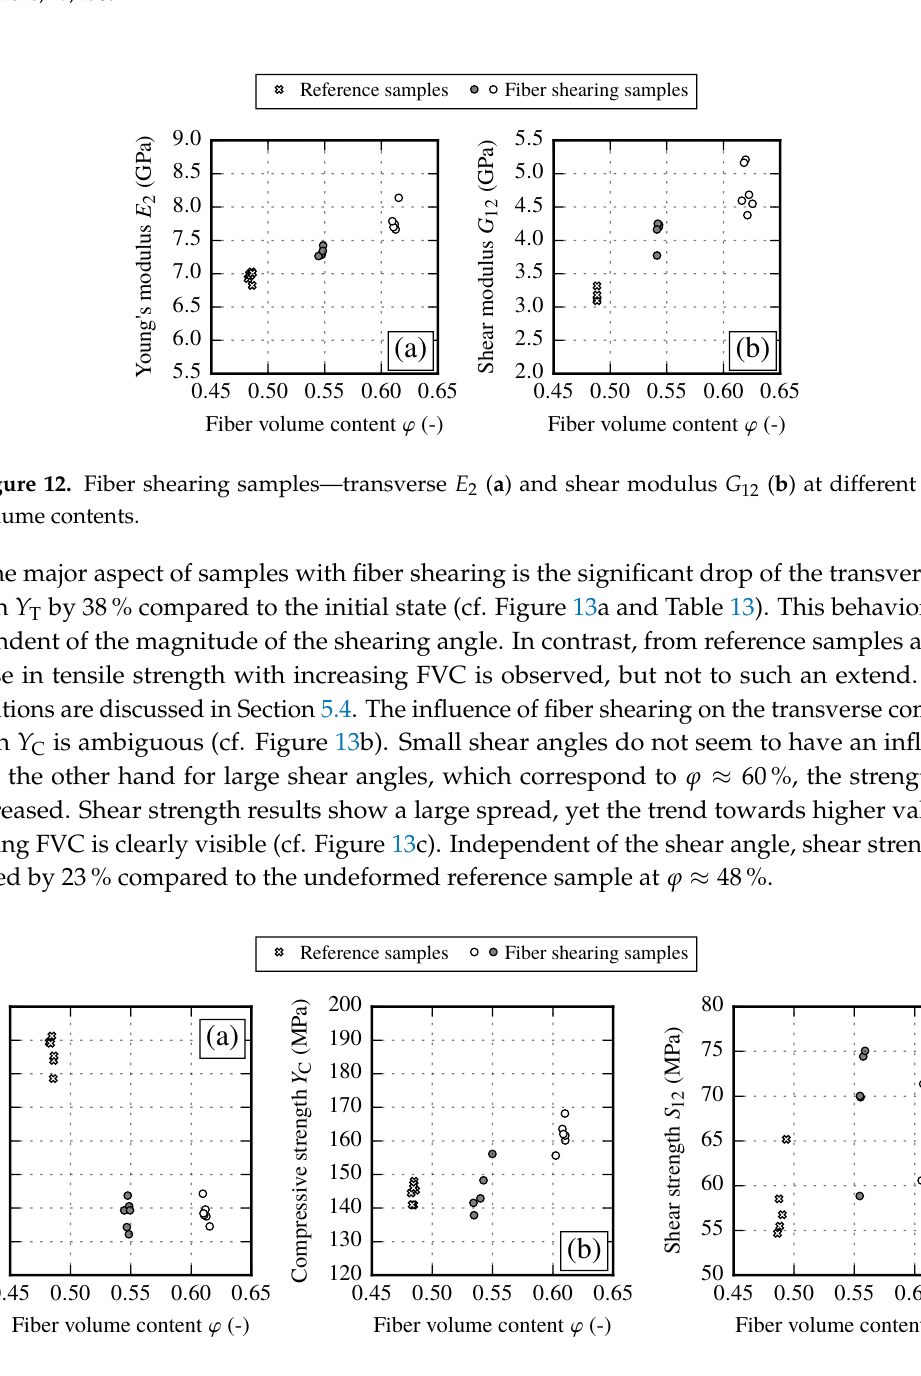
Figure 13. Fiber shearing samples—tensile and compressive strength in transverse direction Y T ( a ) and Y C ( b ); and shear strength S 12 ( c ) at different fiber volume contents. Table 13. Fiber shearing samples—summary of material strength from the initial state ( ϕ ≈ 48%) to different deformation states due to fiber shearing ( ϕ ≈ 54% and ϕ ≈